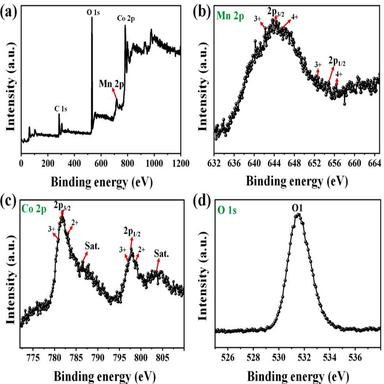
(a) XPS survey spectra of Cu-Co Sulfide nano-reeds arrays electrode material on Ni foam mesh. (b-d) High-resolution XPS spectra for Cu 2p, Co 2p, and S 2p elemental states.